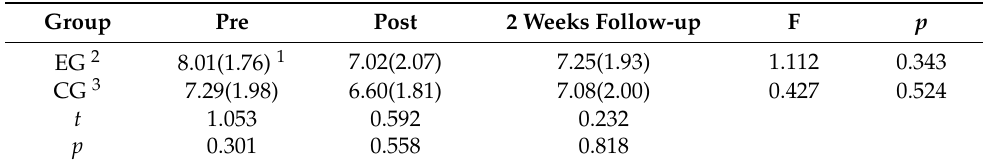
Table 8. Changes in double support time by the period.